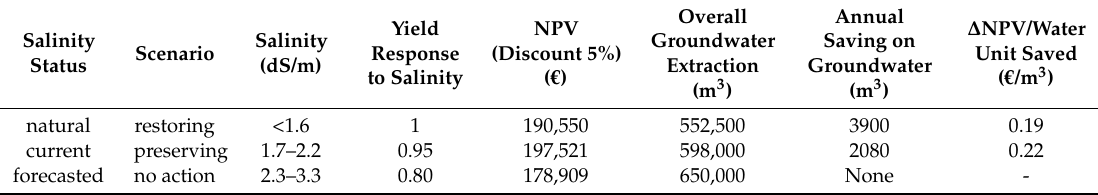
Table 7. Benefits linked to the maintenance of good salinity status (timeframe = 25 years).